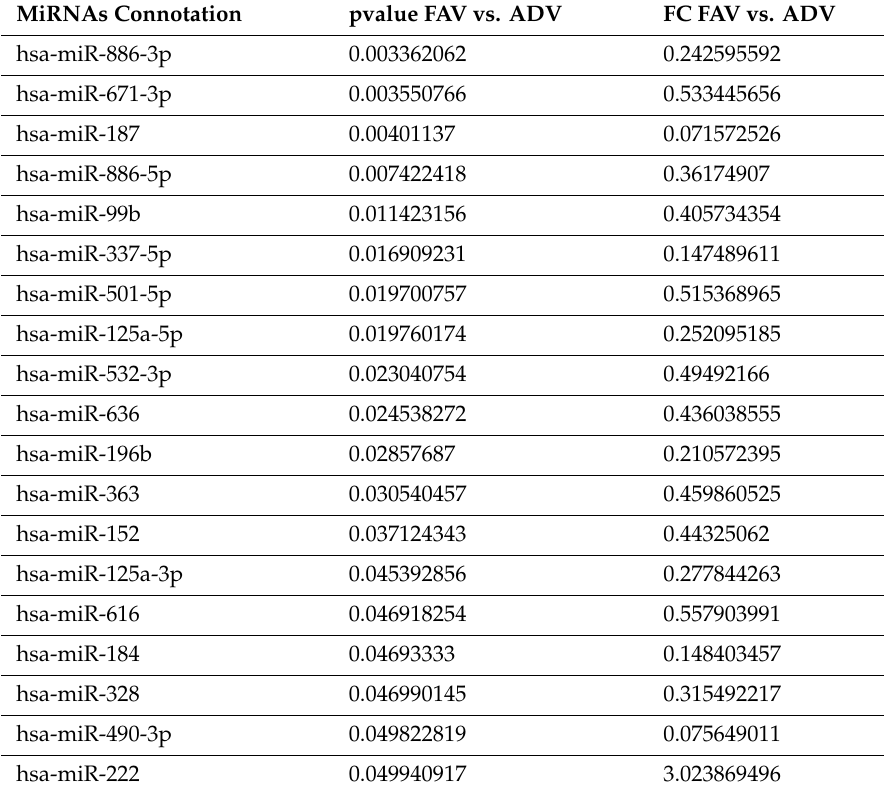
Table 4. Di ff erentially expressed miRNAs based on genetic risk AML Good prognosis (FAV) compared to Adverse risk